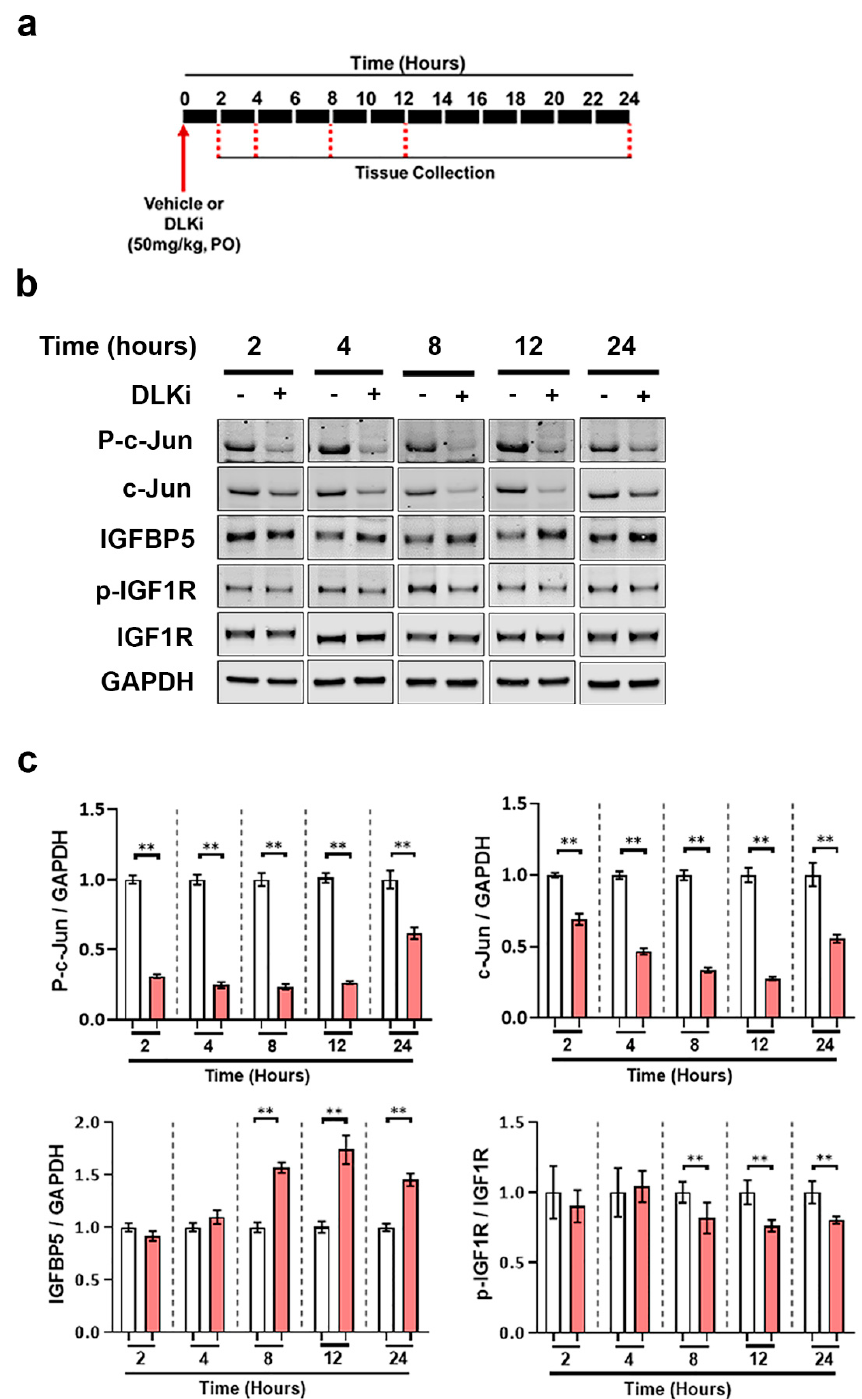
Figure 9. Acute pharmacological inhibition of DLK is sufficient to upregulate IGFBP5 in uninjured mouse cerebellum. ( a ) Schematic representation of study timeline; 3–4 months old male WT mice were treated with a single oral dose of 50 mg / kg of DLKi or vehicle QD. The study was terminated approximately 2, 4, 8, 12, or 24 h after single dose. ( b ) Representative immunoblots of p-c-Jun, c-Jun, IGFBP5, p-IGF1R, and IGF1R from cerebellar homogenates of WT mice treated with a single dose of vehicle or DLKi for either 2, 4, 8, 12, or 24 h. ( c ) Quantification of the immunoblots of p-c-Jun / GAPDH, c-Jun / GAPDH, IGFBP5 / GAPDH, and p-IGF1R / IGF1R from cerebellar homogenates of WT mice treated with single dose of vehicle or DLKi for either 2, 4, 8, 12, or 24 h, plotted as mean fold change relative to vehicle group at respective time-point. Unpaired t -test. * p < 0.05, ** p < 0.01, n =